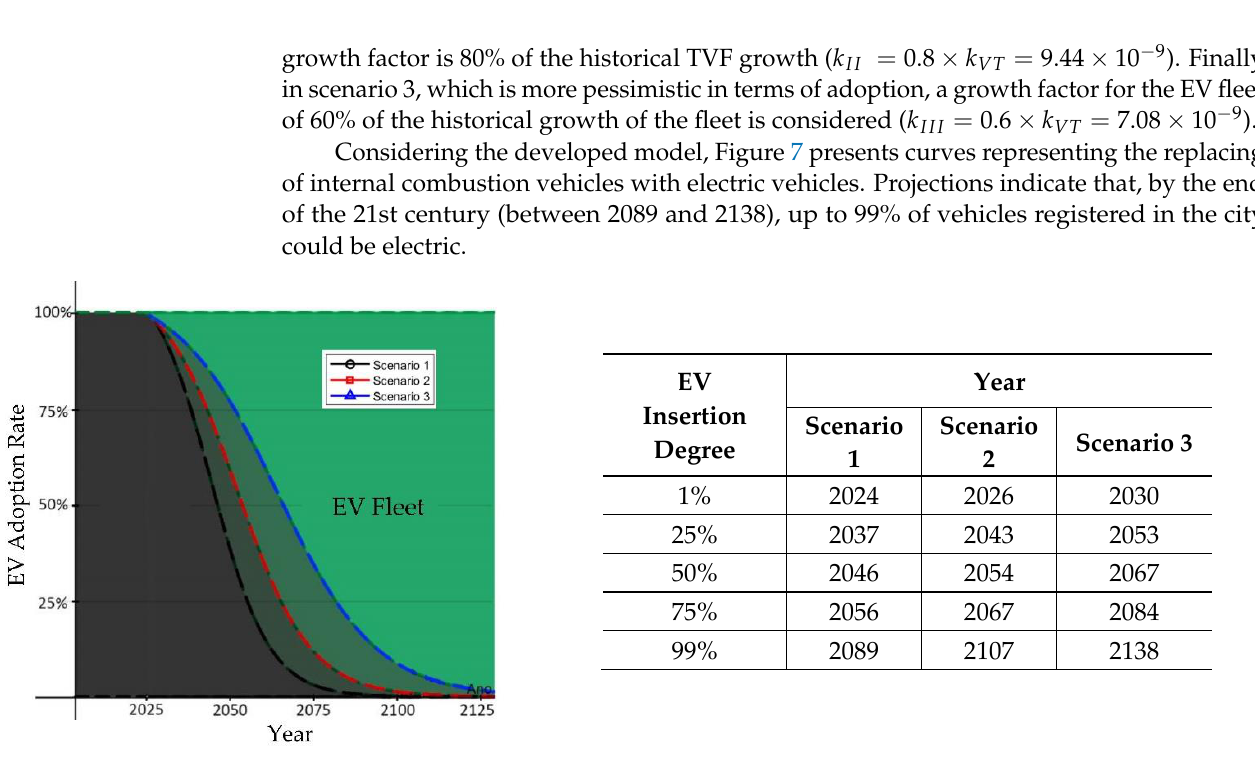
Figure 6. Logistics growth projections for the EV fleet in Campinas. ( a ) Comparison of model output with historical electric vehicle fleet records. ( b ) Scenarios 1, 2, and 3 for the logistical growth curve of the EV fleet in Campinas, for long-term projections.